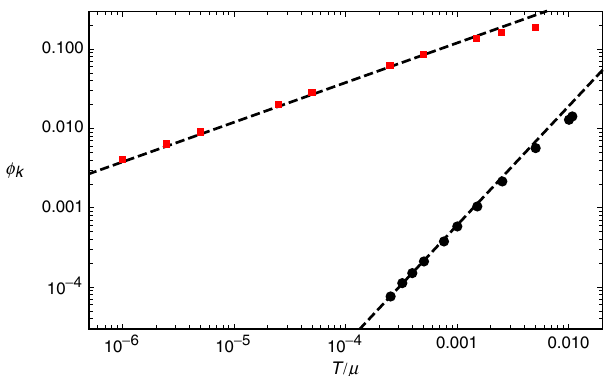
FIG. 6. Numerically obtained ϕ G ΠΠ (red squares) of the charged state. Dashed lines shows the best fits to a power law at small T : ϕ ¼ 3 . 80 ð T= μ Þ 0 . 50 , respectively. ϕ k